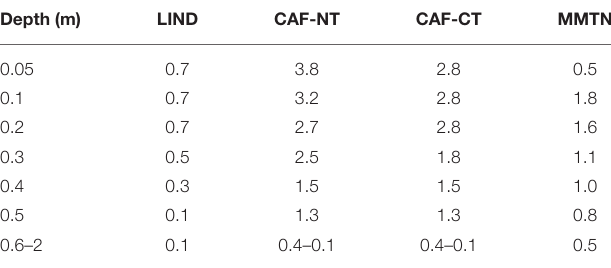
( Figure 3D ). Even though LIND had the lowest RMSE (1.40 g C m − 2 d − 1 ), the other evaluation parameters, such as slope and correlation coefficient indicated fair performance ( Figure 1E